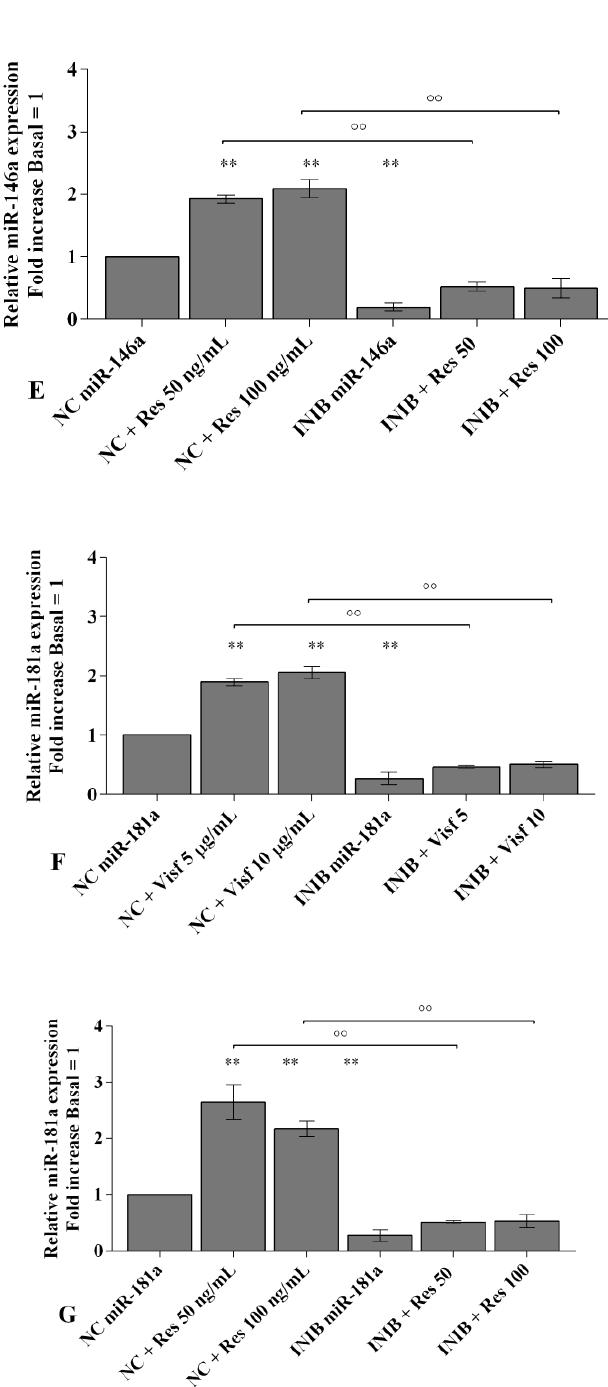
Figure 5. ( A – G ) Expression levels of miR-34a , miR-146a , and miR-181a by real-time PCR. Human osteoarthritic (OA) synovial fibroblasts were evaluated at basal condition, after 24 h of transfection with miR-34a, miR-146a , and miR-181a inhibitors or NC, and after incubation with visfatin (5 and 10 µ g / mL) and resistin (50 and 100 ng / mL). The gene expression was referenced to the ratio of the value of interest and the value of basal condition (basal, cells without treatment) or NC, reported equal to 1. Data were expressed as mean ± SD of triplicate values. ** p < 0.01 versus basal condition or NC. ◦◦ p < 0.01 versus inhibitor. INIB = inhibitor, NC = negative control siRNA, Visf = visfatin, Res = resistin.